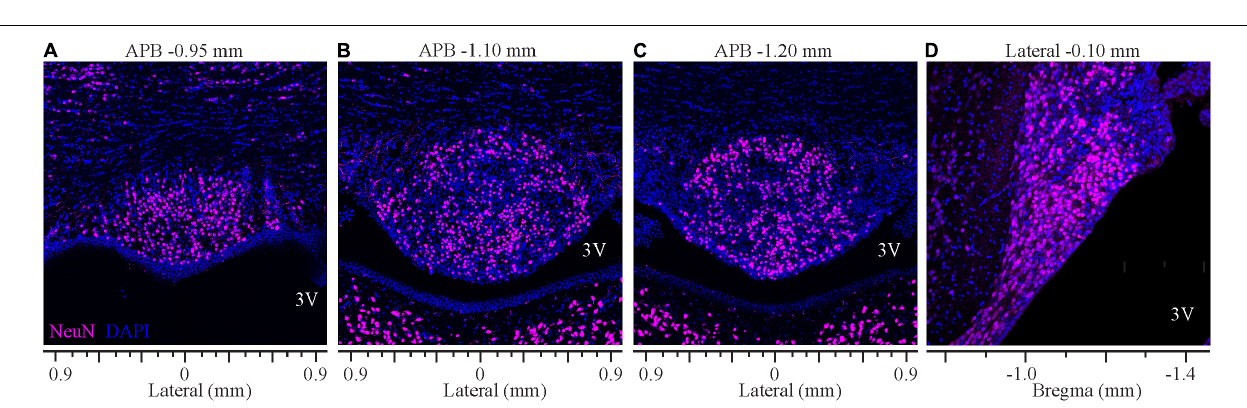
FIGURE 6 | Distribution of neurons in the SFO analyzed in coronal and sagittal planes. Immunohistochemical staining of neurons (NeuN, magenta) and DAPI (blue) of SFO in serial coronal sections of SFO corresponding to APB coordinates –0.95, –1.10, and -1.20 mm (A–C) and the mid-sagittal plane corresponding to the lateral coordinate –0.10 mm (D)